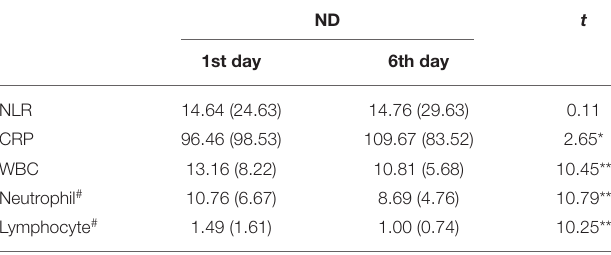
TABLE 3 | Differences in inflammatory markers in ND; mean